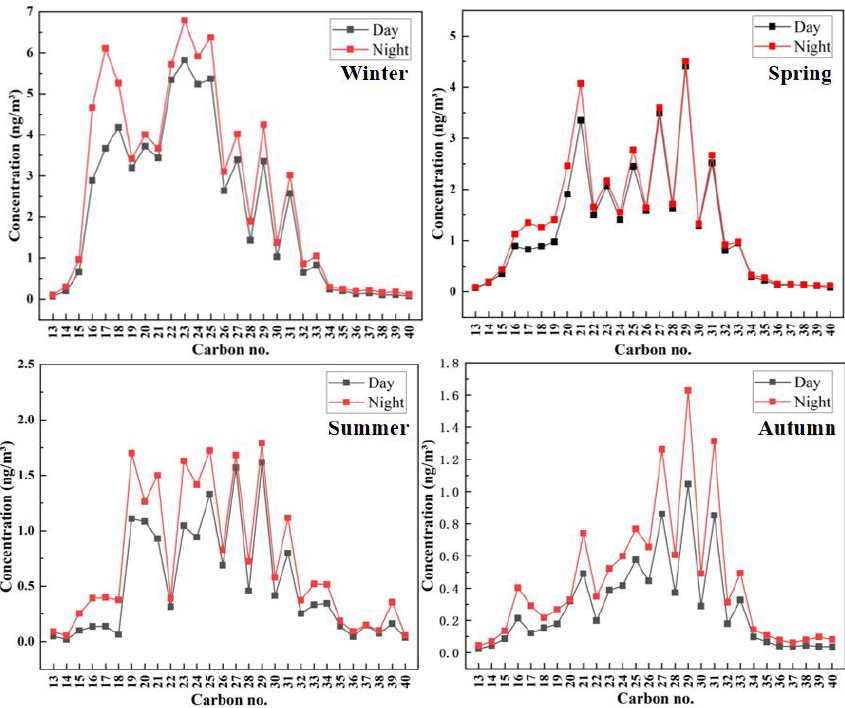
Figure 6. Concentration distributions of the particulate-bound n -alkane homologs in the day and night in the different seasons of Beijing.